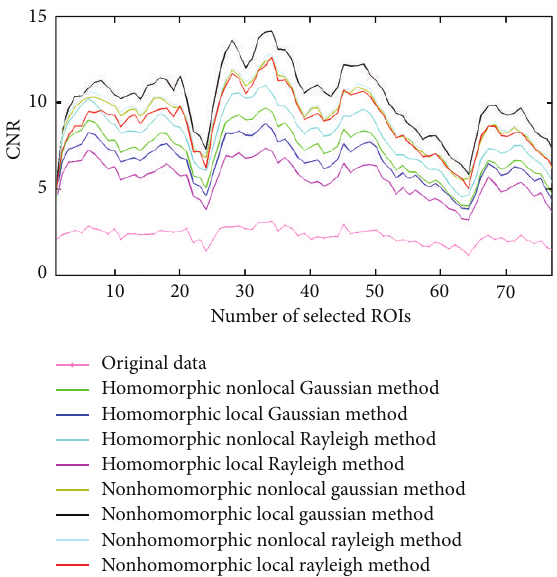
Figure 13: A comparison between CNR curves for 156 selected ROIs from OCT dataset.